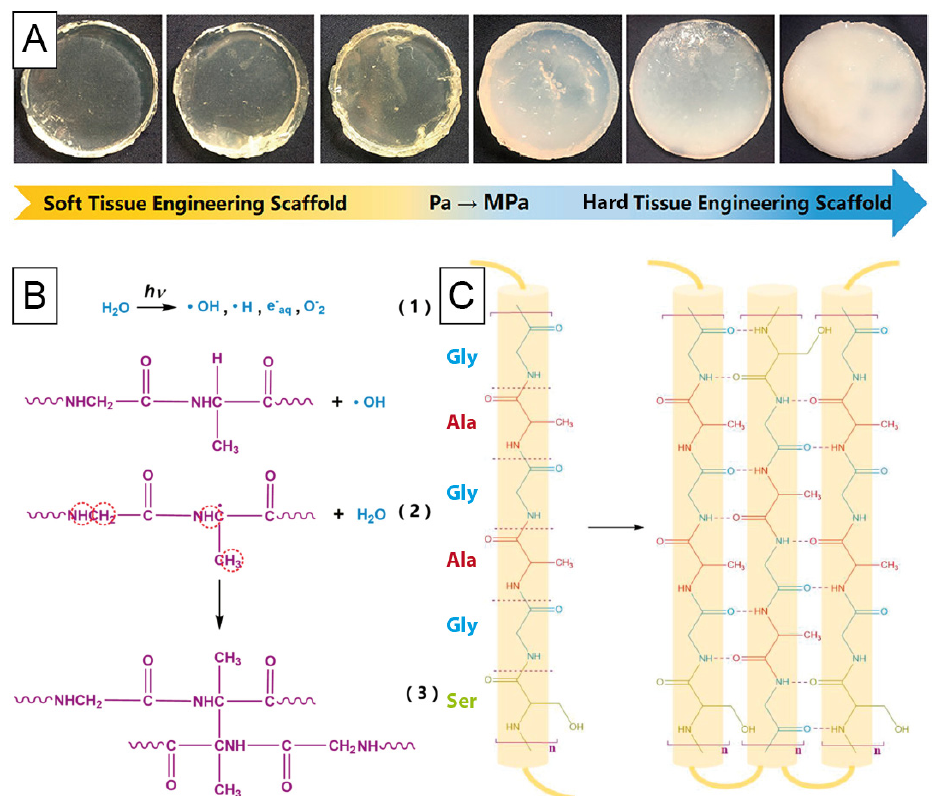
Figure 4. ( A ) Photographs of Bombyx mori silk fibroin hydrogels with a controlled degree of crosslinking using γ -radiation (yellow) and ethanol treatment (blue) to cover six orders of magnitude of material stiffness. Crosslinking mechanism upon ( B ) γ -radiation, triggering radical water splitting and the evolution of free radicals, leading to combinational events between polymer chains and ( C ) ethanol treatment, inducing hydrogen bonding and intermolecular interaction. Reprinted and adopted with permission from ref. [119]. Copyright 2020 American Chemical Society.